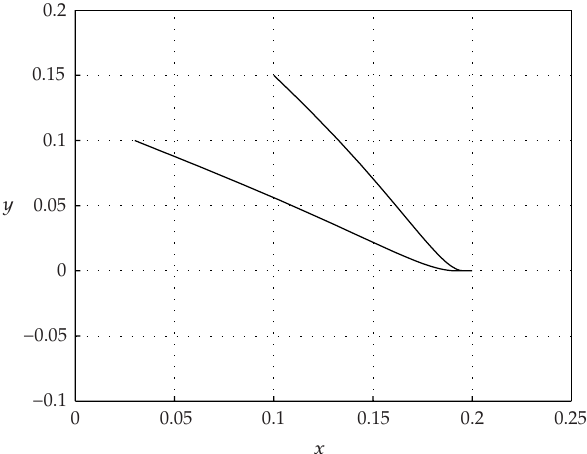
Figure 3: Solution curves for R 0 (cid:8) 0 . 25 with initial value (cid:5) 0 . 03 , 0 . 1 (cid:6) , (cid:5) 0 . 1 , 0 . 15 (cid:6)